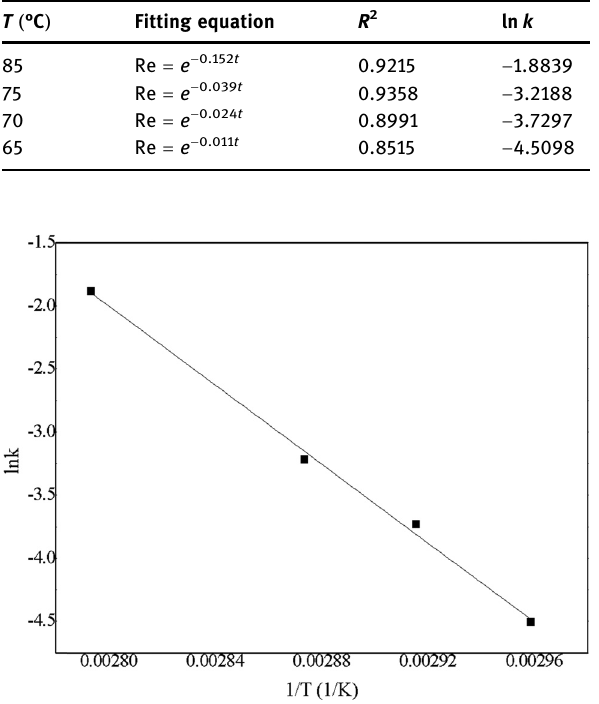
Figure 7: ln k as function of 1/ T . Figure 8: Change behavior of cross - linking density of GaTo at